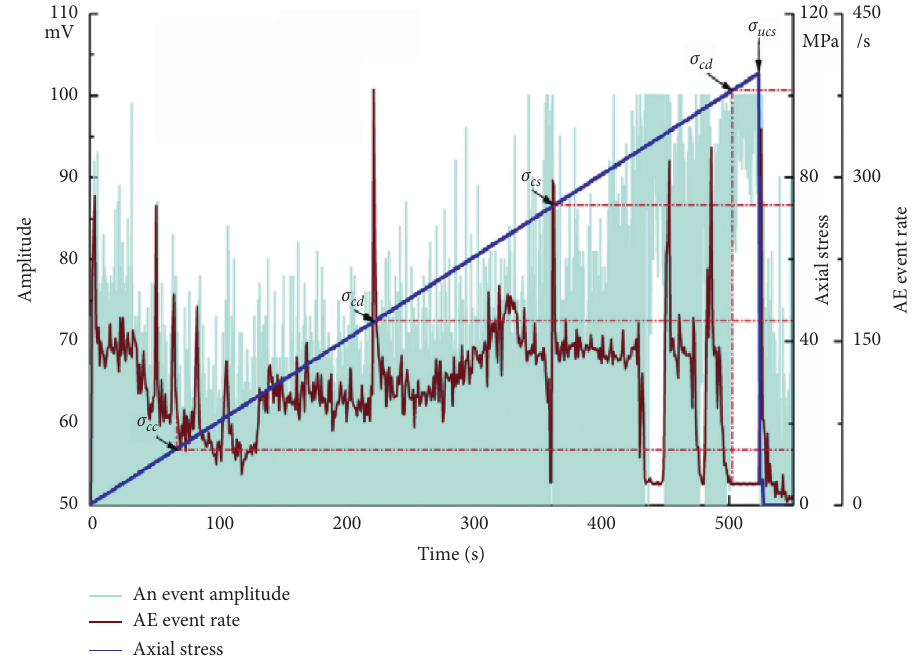
Figure 4: AE event rate, amplitude, and stress versus time curves.